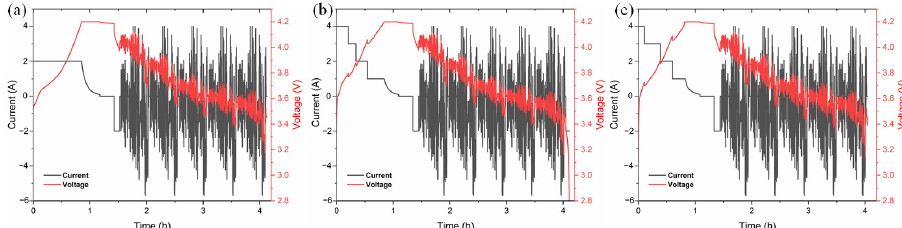
Figure 3. Battery testing using different charging strategies for charging and the WLTP driving cycle for discharging to investigate the effect of multi ‐ step charging strategies on battery degradation; ( a ) CC ‐ CV charging and five WLTP cycles applied for discharging; ( b ) multi ‐ step CC ‐ CV charging (MCCCV1) charging and five WLTP cycles applied for discharging; ( c ) MCCCV2 charging and five WLTP cycles applied for discharging.